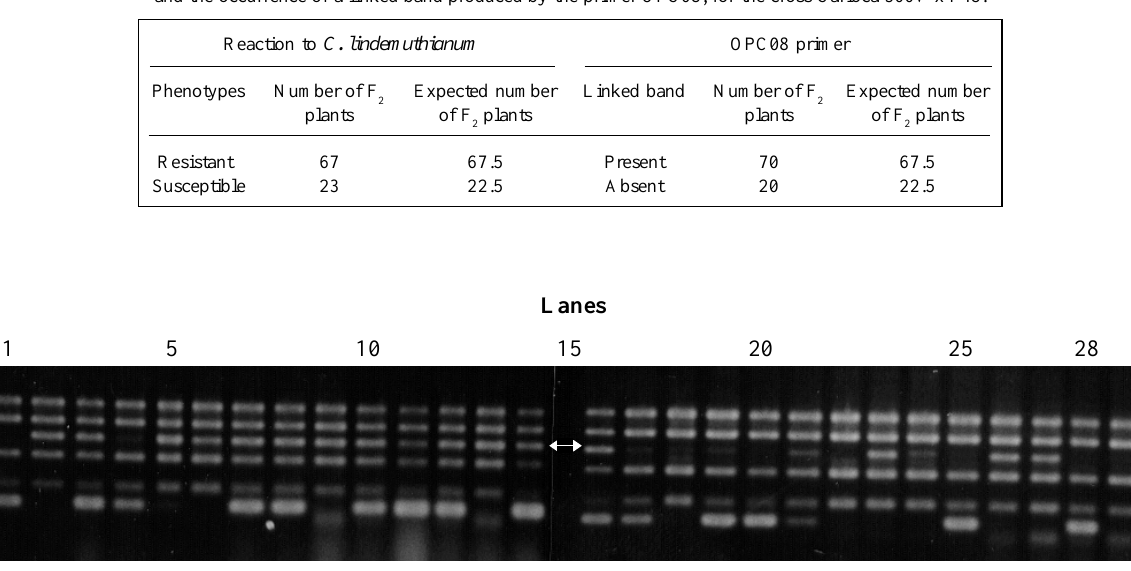
Figure 2 - RAPD pattern produced by the primer OPF10 in the parents and components of resistant and susceptible bulks. The band indicated by the arrow is linked to the Co.5 allele. The band pattern of the Carioca 300V parent (lane 1), Ouro parent (lane 2), resistant DNA pool (lanes 3 and 15), susceptible DNA pool (lanes 4 and 16), homozygous resistant plants (lanes 5-14), and homozygous susceptible plants (lanes 17-28) are shown.